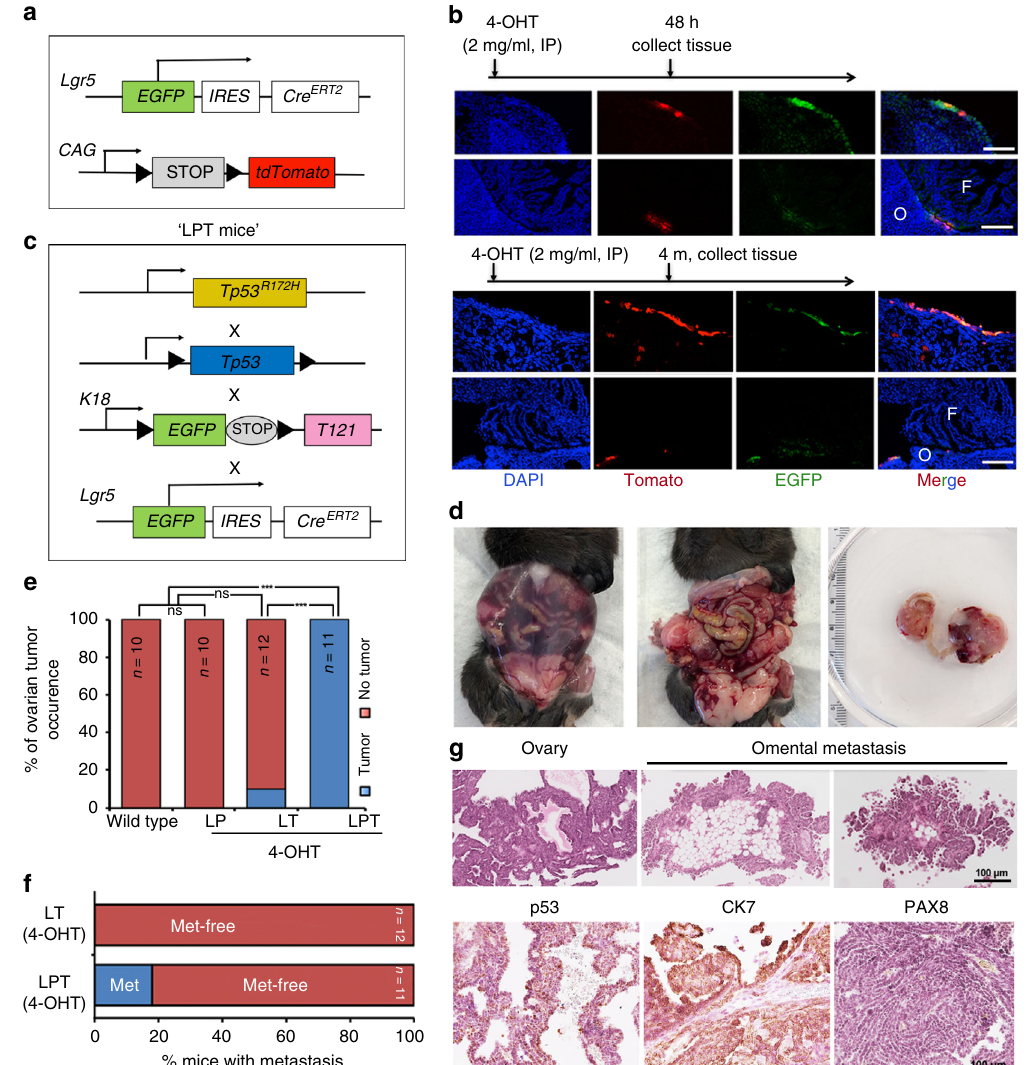
Fig. 4 Combined Tp53 mutation/RB family inactivation in Lgr5 + OSE also causes HGSOC. a Scheme depicting Lgr5Cre ; Rosa26-tdTomato mice. b EGFP co- immunostaining of Tomato + OSE clone in ovary and fallopian tube sections, 48 h or 4 months post 4-OHT induction of Lgr5-Cre;Rosa26-tdTomato mice; scale bars, 50 μ m; O ovary; F fallopian tube. c Scheme depicting Lgr5Cre ERT2 ; T121 ; Tp53 R172H/ − (LPT) mice. d Exposed abdominal cavity of LPT mouse at 11 months after 4-OHT treatment, showing abdominal distention from ascites, large ovarian tumors and peritoneal studding. e % of mice of the indicated genotypes with ovarian tumors at 18 months post 4-OHT induction, *** P < 0.001, Fischer ’ s exact test. f % LT and LPT mice with peritoneal metastasis at 18 months after 4-OHT treatment. g Representative p53, CK7, and PAX8 staining (by IHC) in metastatic tumor from LPT